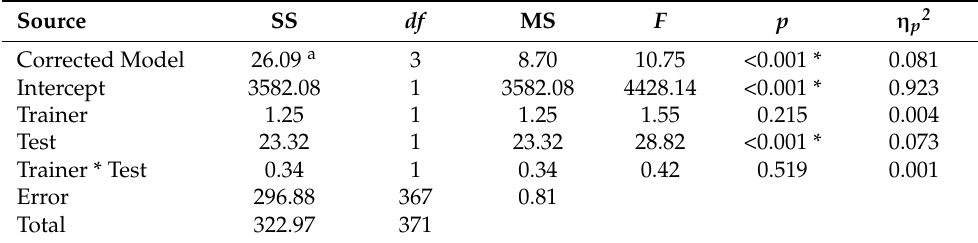
Table 8. Two-way ANOVA for knowledge of trauma-informed schools ( n =